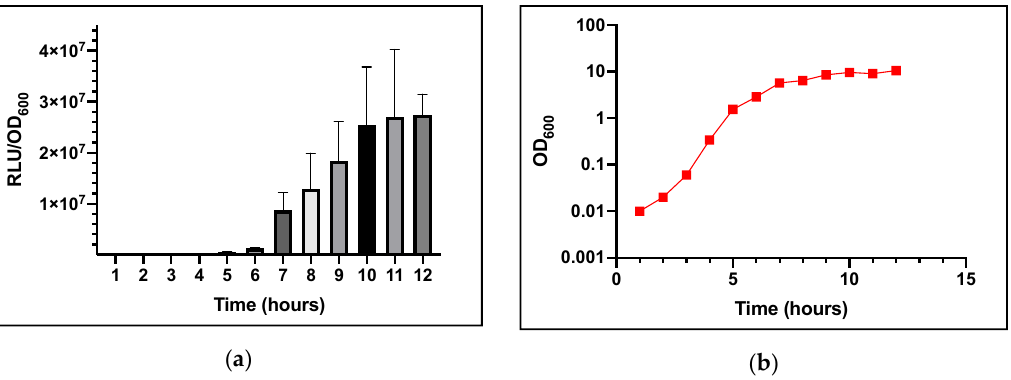
Figure 2. Bioluminescence from S. aureus strain USA300 agr P3-GLuc over time. ( a ) Bioluminescence output. ( b ) Bacterial growth (OD 600 ). Data are representative of three technical repeats and three biological repeats for each sample with error bars displaying standard deviations.